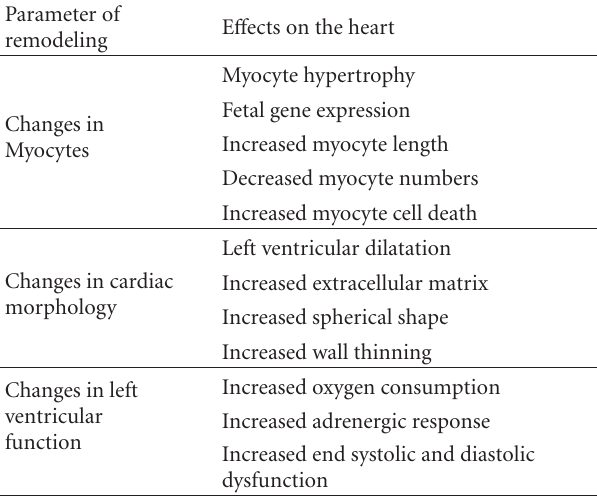
Table 2: Summary of factors in Post-MI remodeling and heart failure.